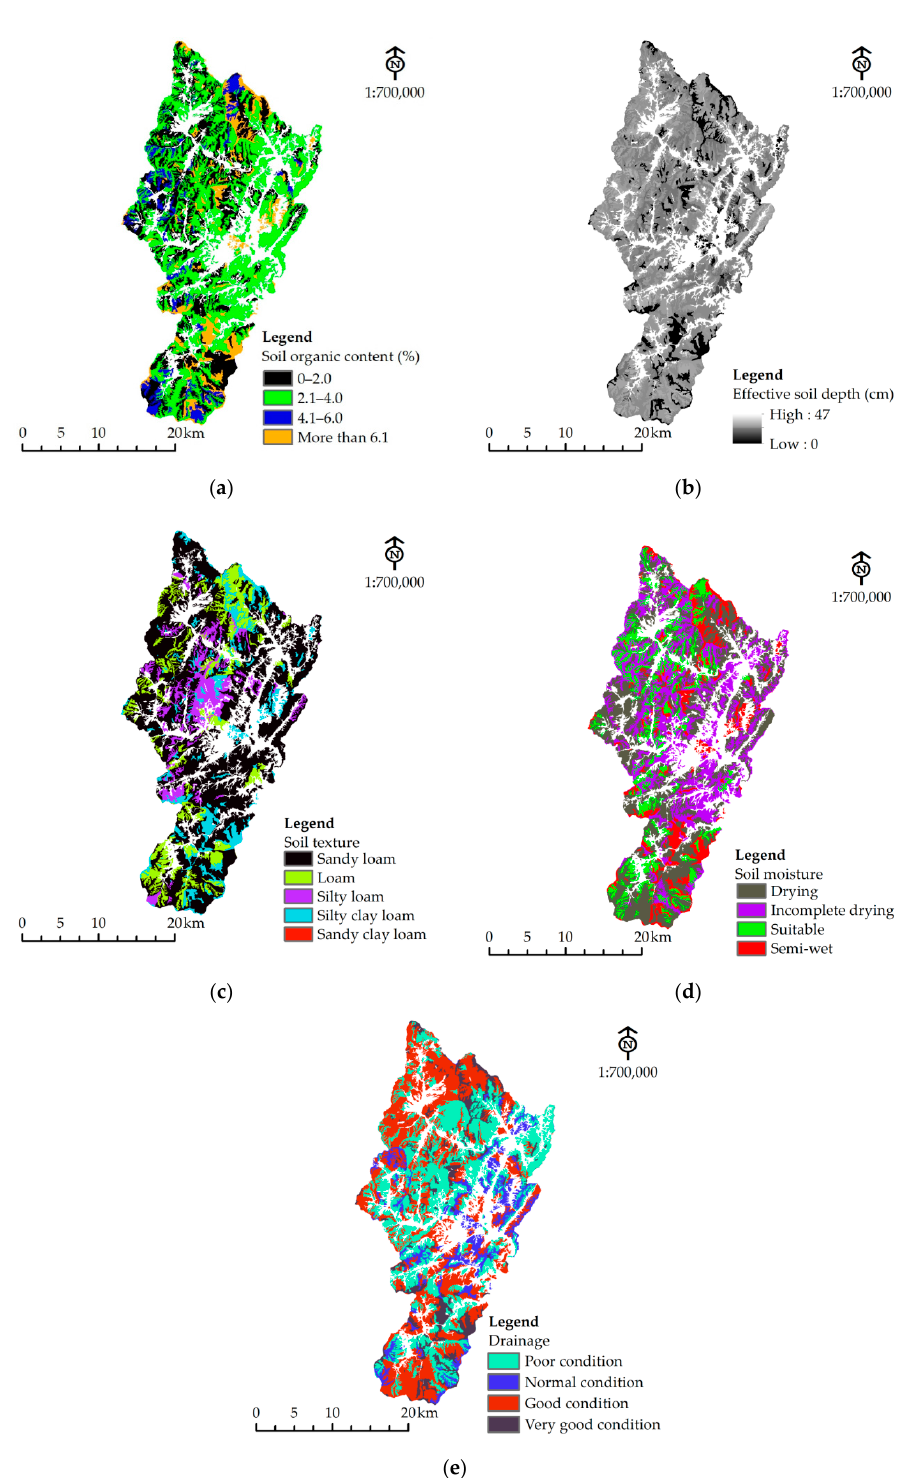
Figure 5. Thematic map for each growth factor of WSG using the forest soil map; ( a ) thematic map for soil organic content aspects within the study area; ( b ) thematic map for effective soil depth within the study area; ( c ) thematic map for soil texture within the study area; ( d ) thematic map for soil moisture with the study area; ( e ) thematic map for drainage within the study